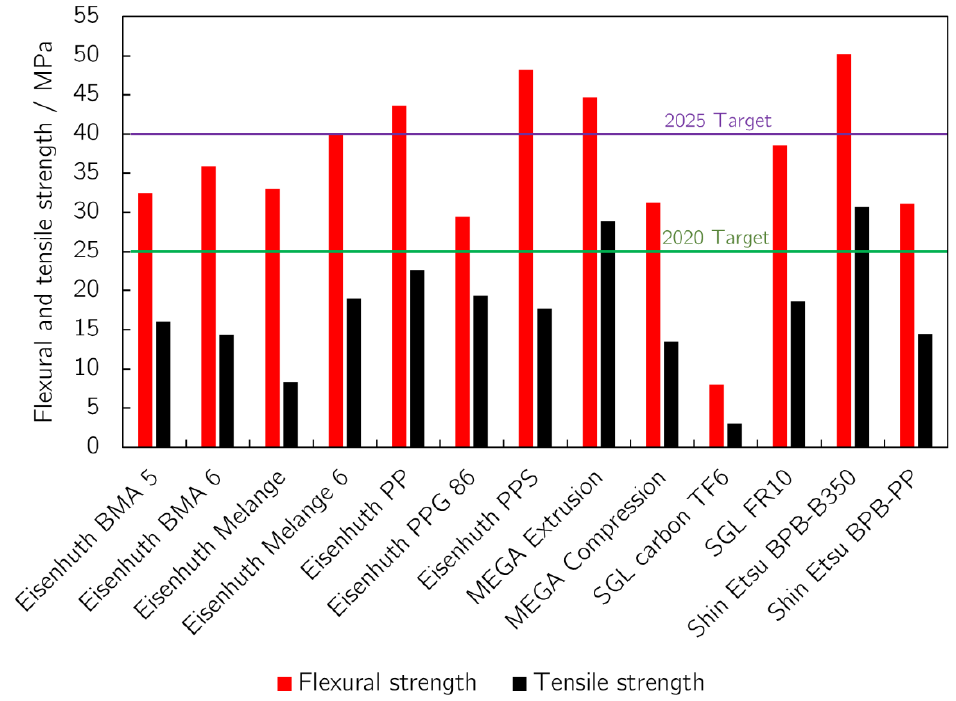
Figure 7. Flexural and tensile strength of the BPs tested. DOE 2020 and 2025 target values [23,24] for flexural strength are shown as green and purple lines, respectively.